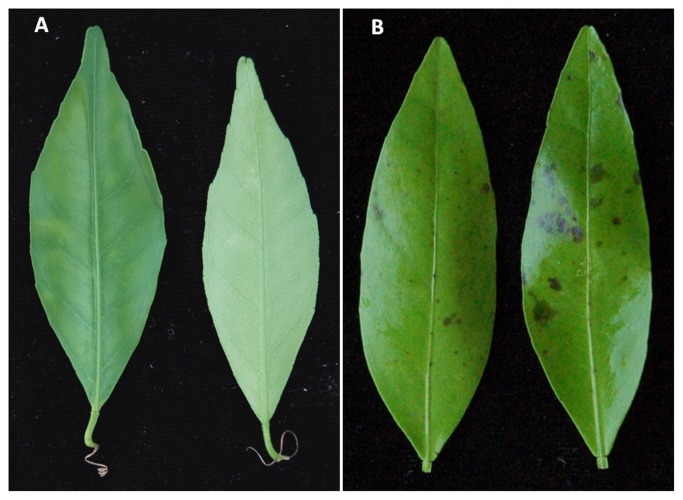
Leaves of resistant genotype ‘Willowleaf’ mandarin (A) and susceptible genotype ‘Fortune’ mandarin (B) showing ABS symptoms 48h after inoculation with a suspension of 105 conidia·ml-1.